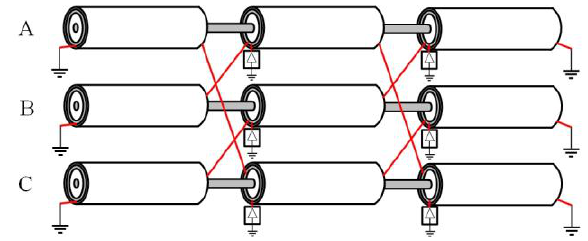
Figure 2. Typical structure of cross-connection grounding.